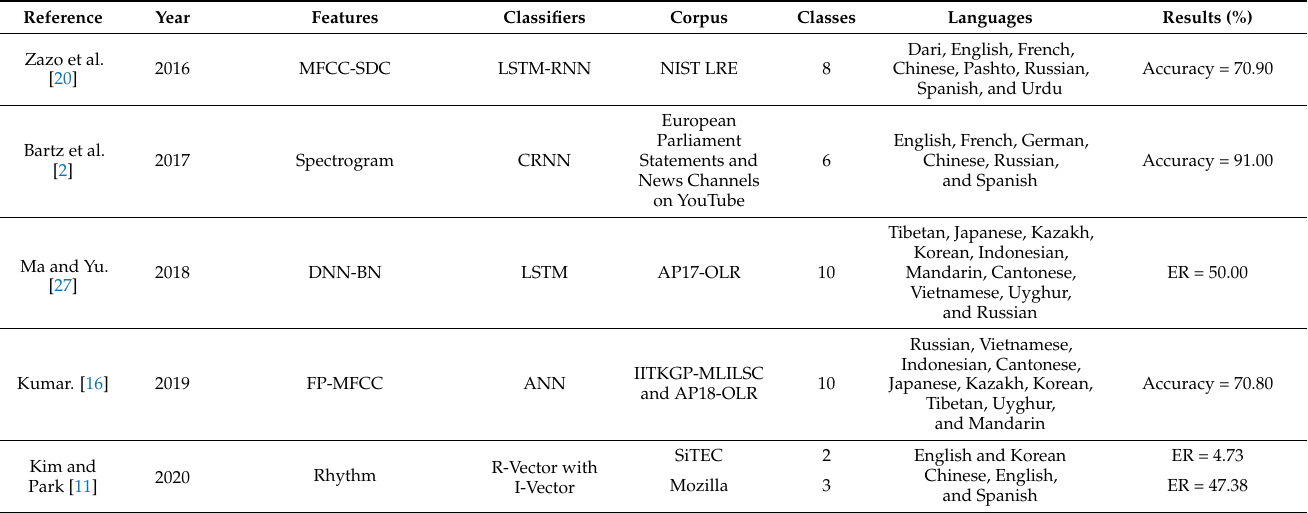
Table 1. Review of previous literature on spoken language identification with